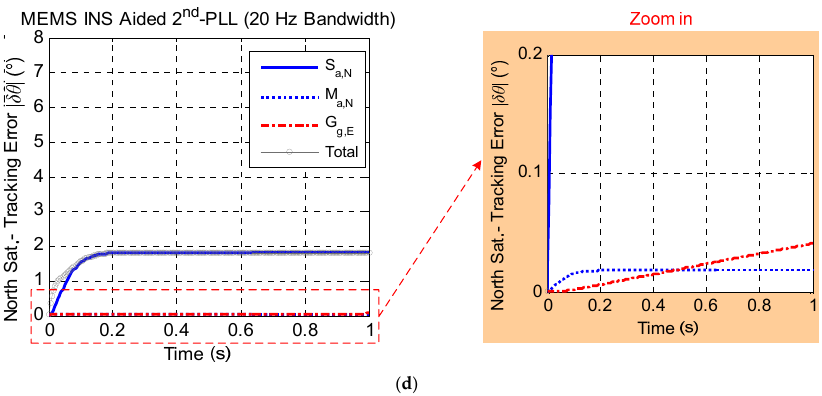
Figure 5. The north satellite tracking error caused by MEMS INS error sources under the assumption of linear high dynamics along the north direction. ( a ) Effect of non-maneuver-dependent error with a 10-Hz bandwidth; ( b ) effect of maneuver-dependent error with a 10-Hz bandwidth; ( c ) effect of non-maneuver-dependent error with a 20-Hz bandwidth; ( d ) effect of maneuver-dependent error with a 20-Hz bandwidth. PLL, phase-locked loop. (* Here, Sat. is the abbreviation of satellite.)